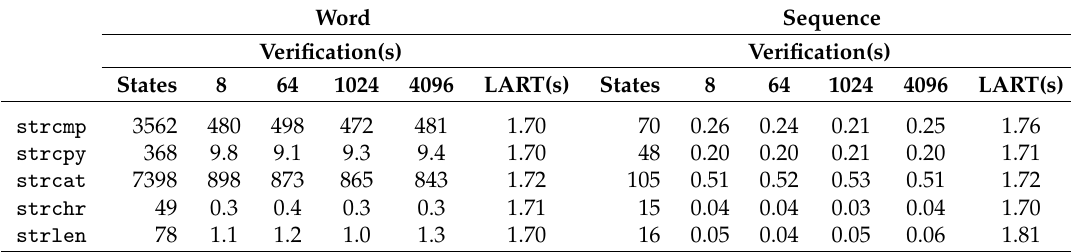
Table 2. Measurements of M-String operations on two types of inputs: Word and Sequence described in Section 8.1. Each benchmark measures a size of state space and verification time for input M-Strings of a given length. Lastly, the table shows an average transformation time ( LART ). All measurements of time are in seconds. The size of state space does not change for different lengths of input—for more details, see discussion in Section 8.1.